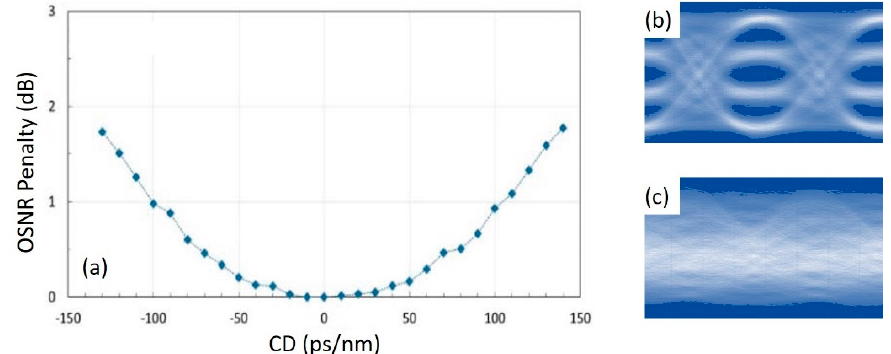
Figure 3. ( a ) Four-level pulse amplitude modulation (PAM4) signaling tolerance on dispersion in terms of optical signal-to-noise ratio (OSNR) penalty (reprinted from [62] with permission from authors). Eye diagrams for 56 Gbps PAM4 signal after ( b ) 0 km and ( c ) 20 km transmission.